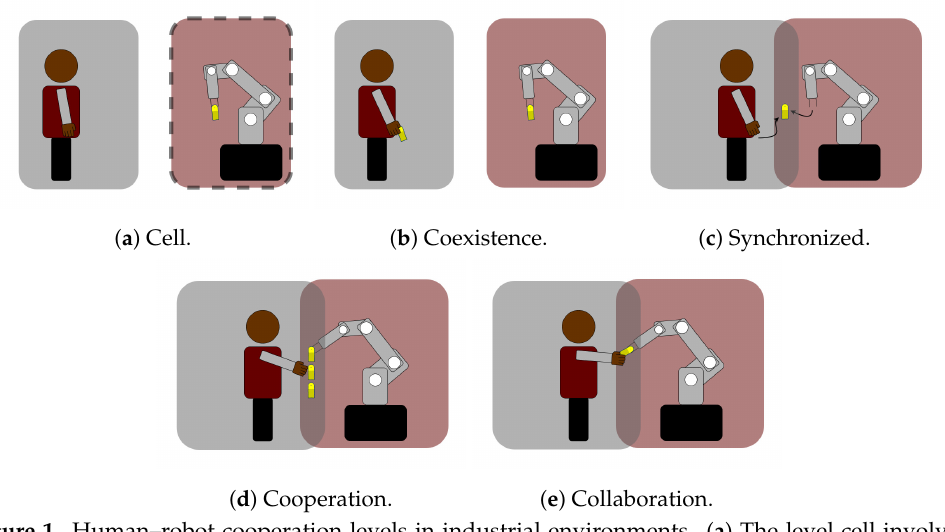
Figure 1. Human–robot cooperation levels in industrial environments. ( a ) The level cell involves no collaboration at all; the robot remains held inside a work cell. ( b ) Coexistence removes the cell, but humans and robots do not share the workspace yet. ( c ) Synchronized allows the sharing of the workspace, but never at the same time; humans and robots operate in a synchronized manner. ( d ) At the level cooperation, the task and the workspace are shared, but humans and robots do not physically interact. ( e ) The level collaboration considers full collaboration where operators and robots exchange forces.